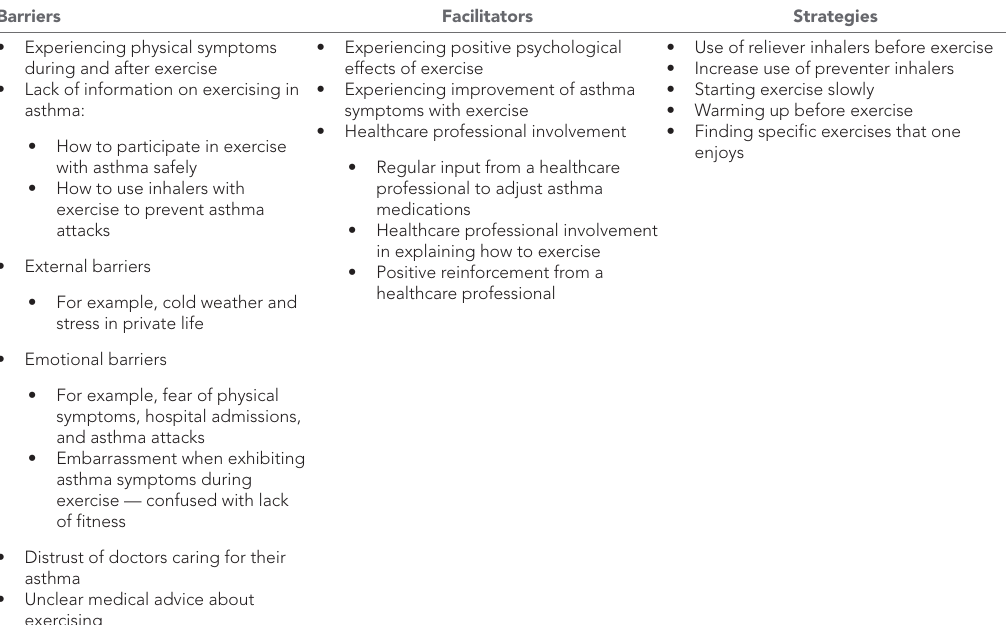
Table 2 Themes and sub- themes emerging from posts, divided into barriers, facilitators, and strate-